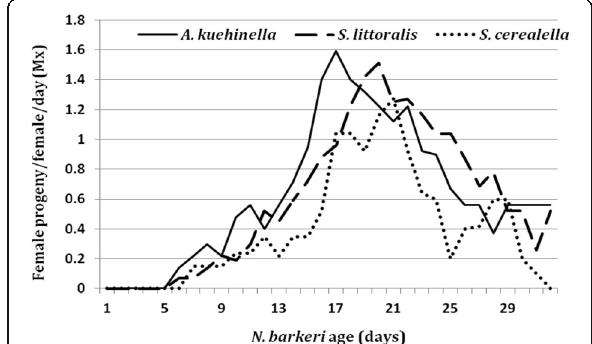
Fig. 3 Age-specific fecundity of Neoseiulus barkeri fed eggs of Anagasta kuehniella , Spodoptera littoralis , and Sitotroga cerealella and incubated at 27 °C and 65%